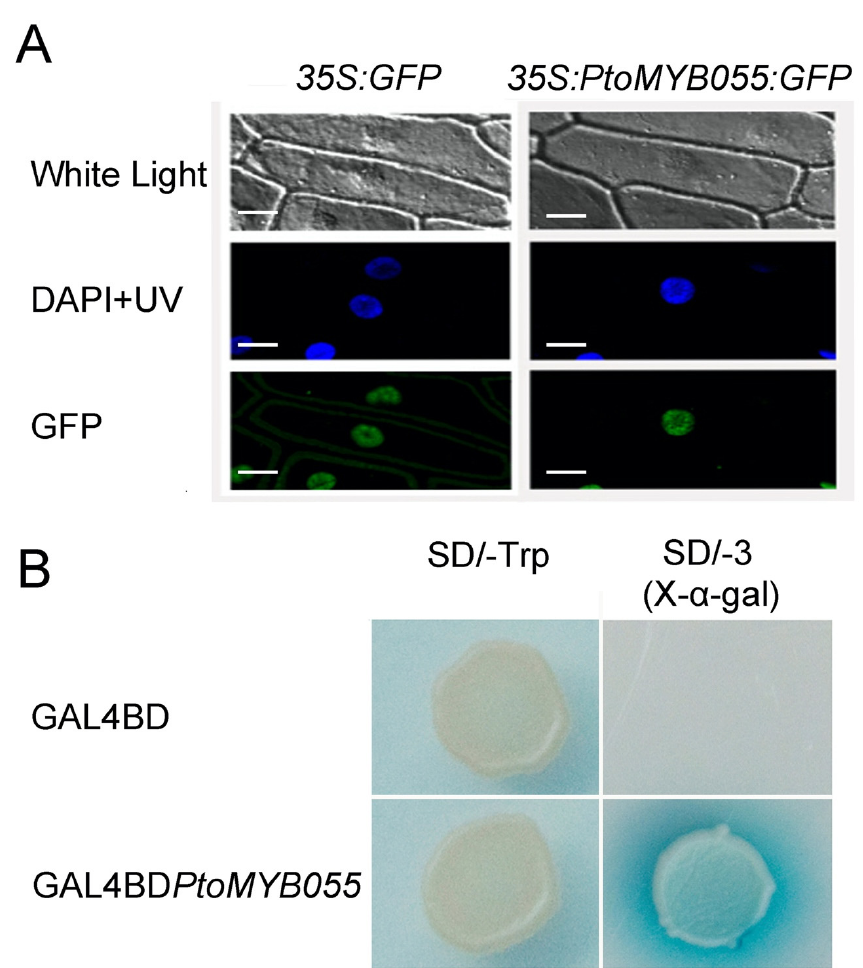
Figure 3. Nuclear localization and transcription activity. ( A ) 35S:Pto-MYB216:GFP and 35S:GFP transformed to onion epidermis. GFP fluorescence was observed with a confocal microscope 18 h after bombardment. The position of the nucleus was confirmed with DAPI staining and compared to a bright field, scale bar = 50 µm. ( B ) PtoMYB055 has trans-activation activity in yeast. On a medium without histidine, adenine, and tryptophan, yeast containing recombinant plasmid, GAL4BD PtoMYB055 , appeared blue. This shows that PtoMYB055 induce the activity of X-b-gal.